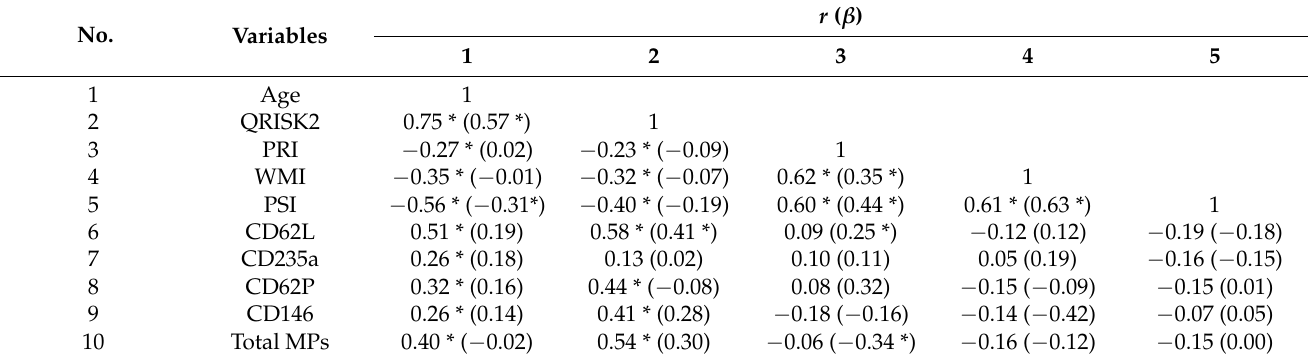
Table 3. Correlation and linear regression profile of study